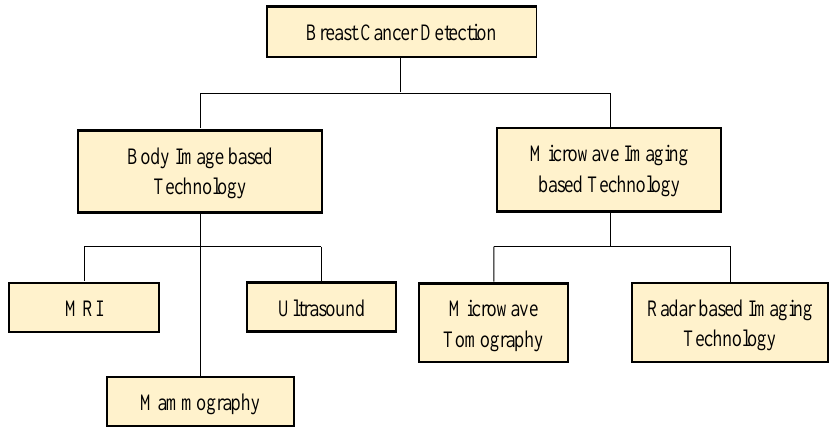
Figure 3. Block diagram showing the different modalities in breast cancer